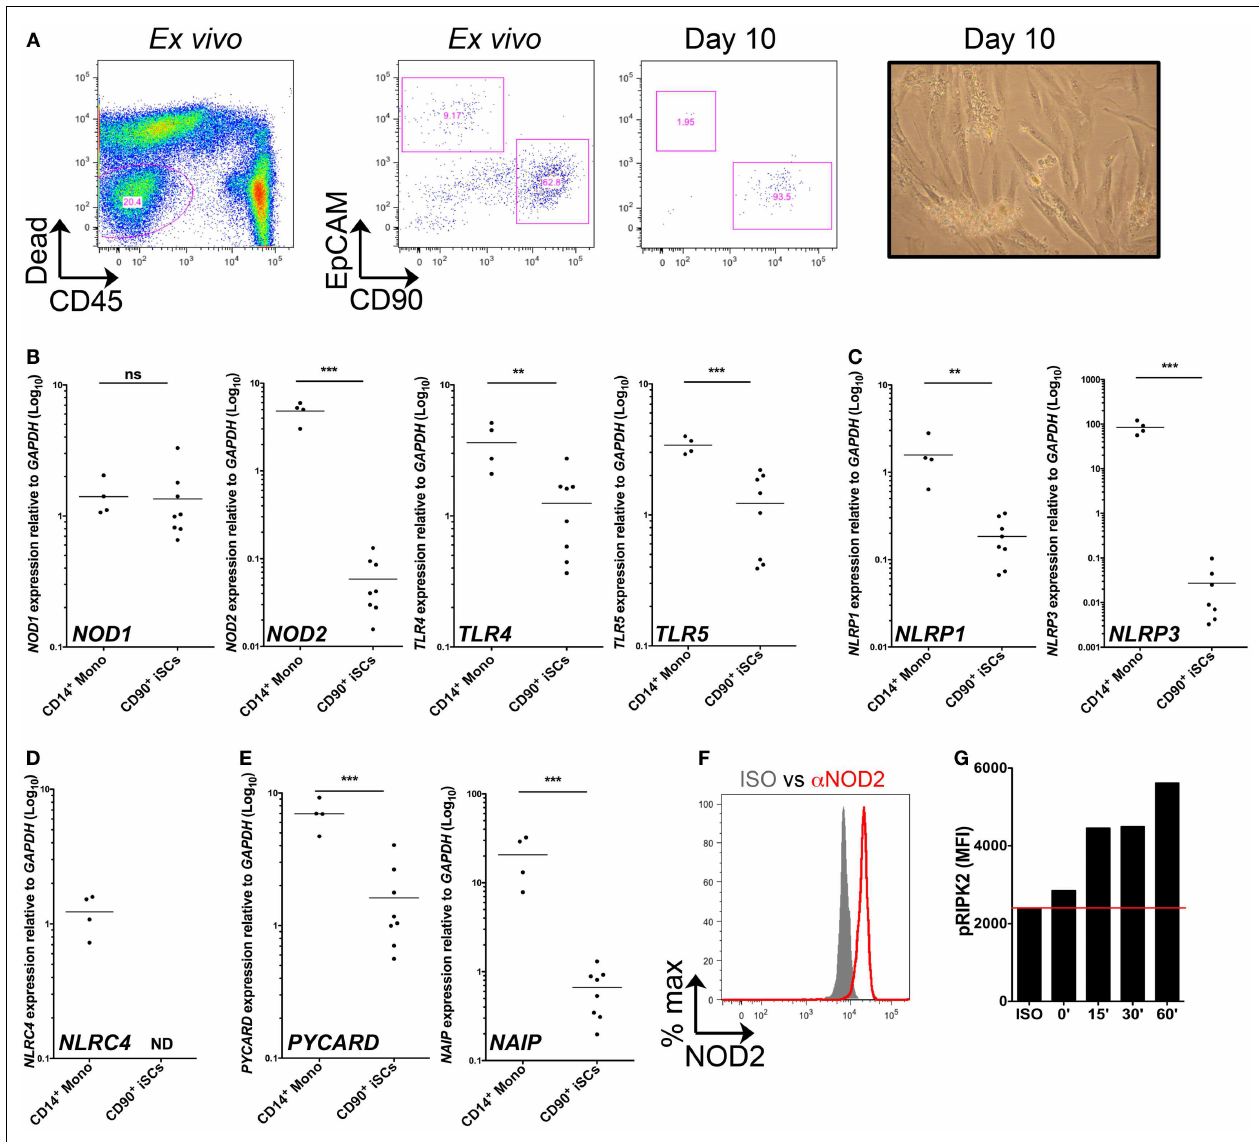
by intracellular flow cytometry; gray filled histogram indicates isotype control, red open histogram indicting specific staining. (G) Shows accumulation of phosphorylated RIPK2 in cultured iSCs determined by flow cytometry after stimulation for the indicated time periods with MDP. Data in (A) are representative of tissue, (B–E) are from monocytes isolated from n = 4 healthy peripheral blood donors and iSCs cultured from colonic tissue of n = 8 uninflamed surgical patients. Data in (F,G) are from iSCs of one patient, representative of four patients with similar results. ** p < 0.01, *** p <